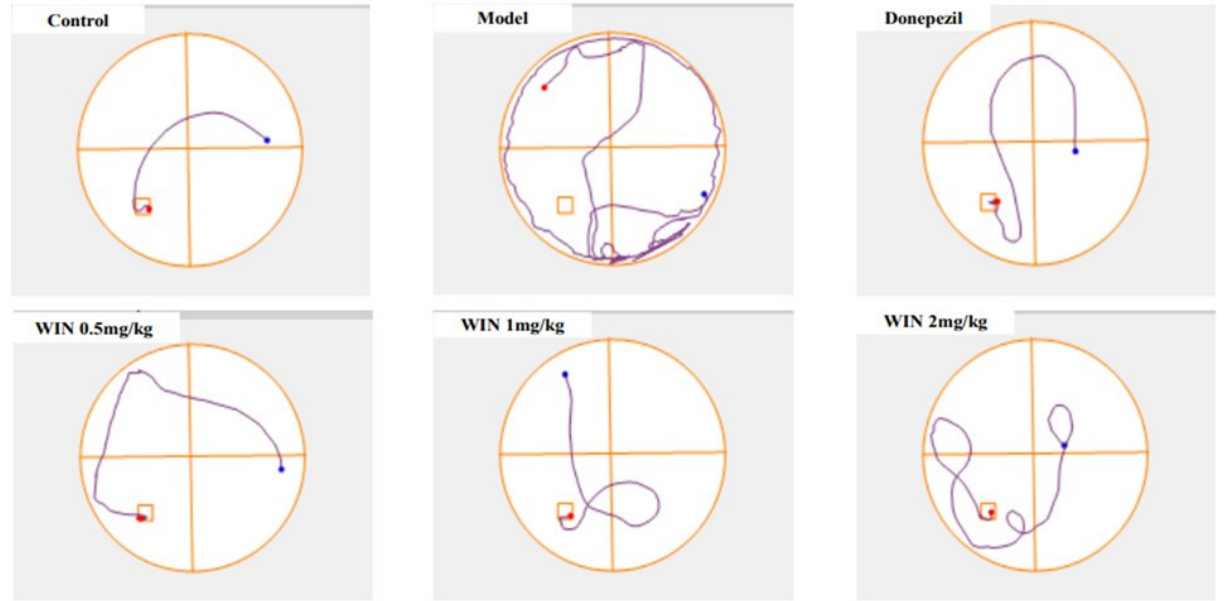
Figure 3. Representative images of track plots of spatial learning in AlCl 3 and D -gal-induced cognitive impaired rats on day 5. The experimental groups include; group Normal saline + Distilled water, (control), Model (AlCl 3 200 mg/kg + D -gal 60 mg/kg), positive control (Model + Donepezil 1 mg/kg, positive control), WIN low (Model + WIN55,212-2 0.5 mg/kg), WIN medium (Model + WIN55,212-2 1 mg/kg) and WIN high (Model + WIN55,212-2 2 mg/kg), n = 6 for each